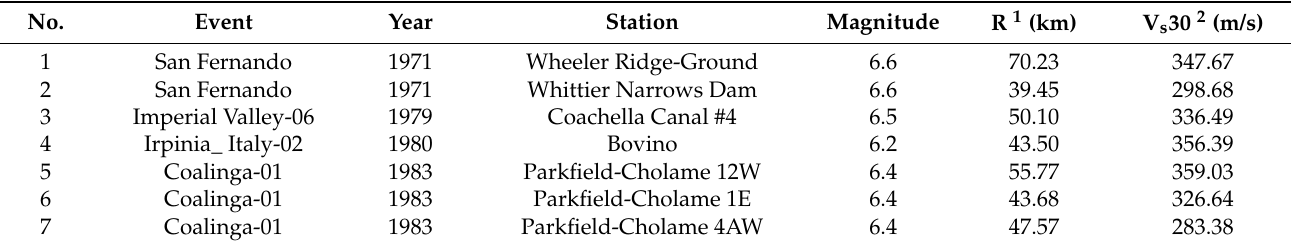
Table A1. Selected record